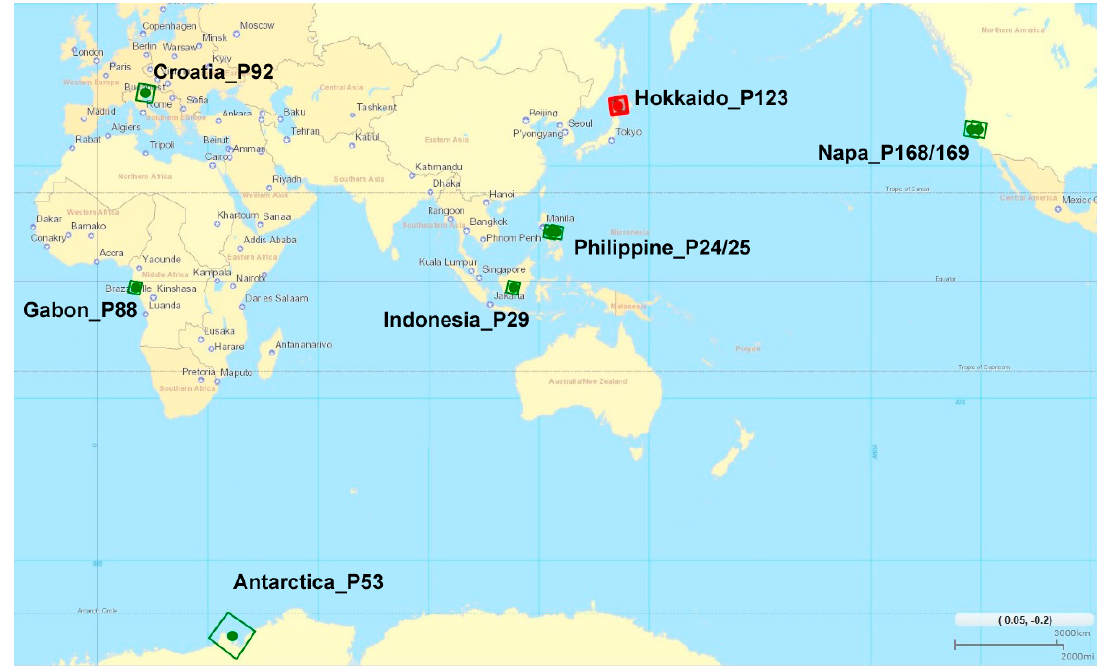
Figure 1. Positions of the sampled paths/frames.